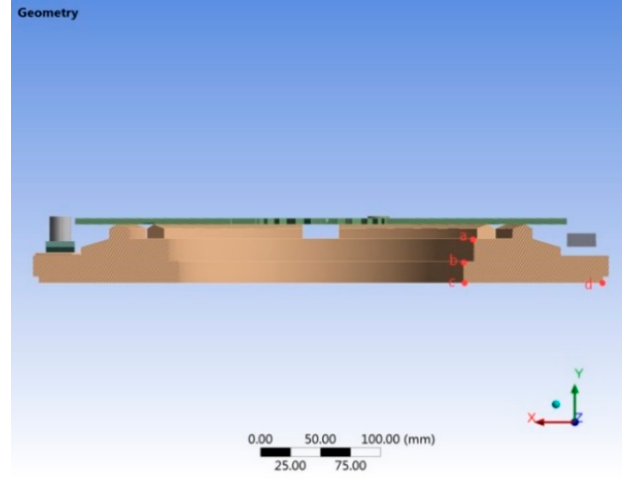
Figure 9. Key points on the pressure plate as well as the axial and chassis surfaces.